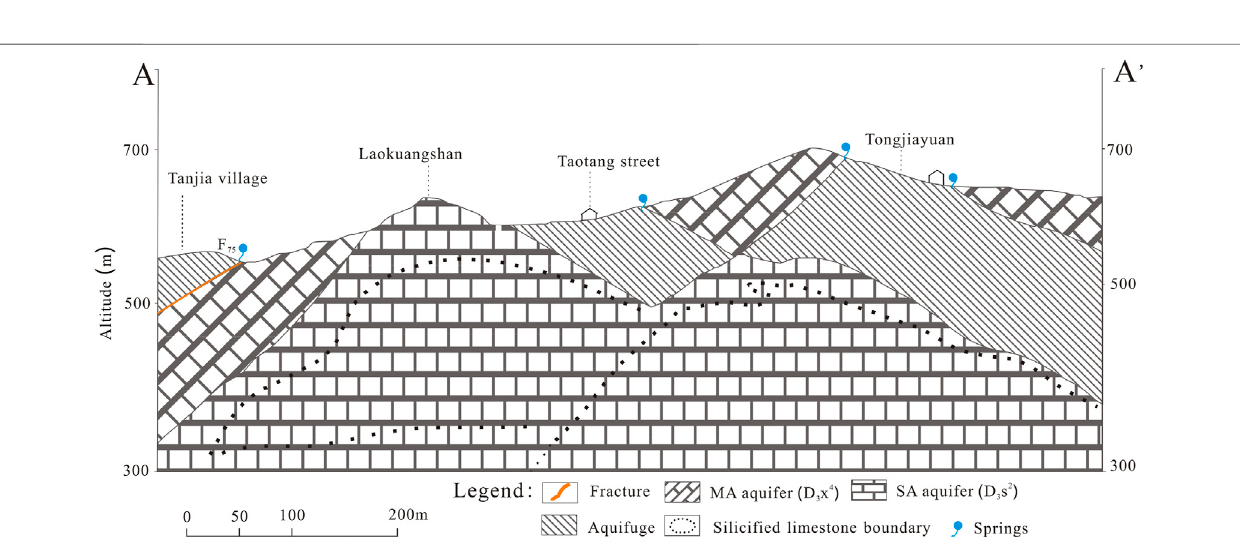
FIGURE 2 | The hydrogeological section along the A-A ’